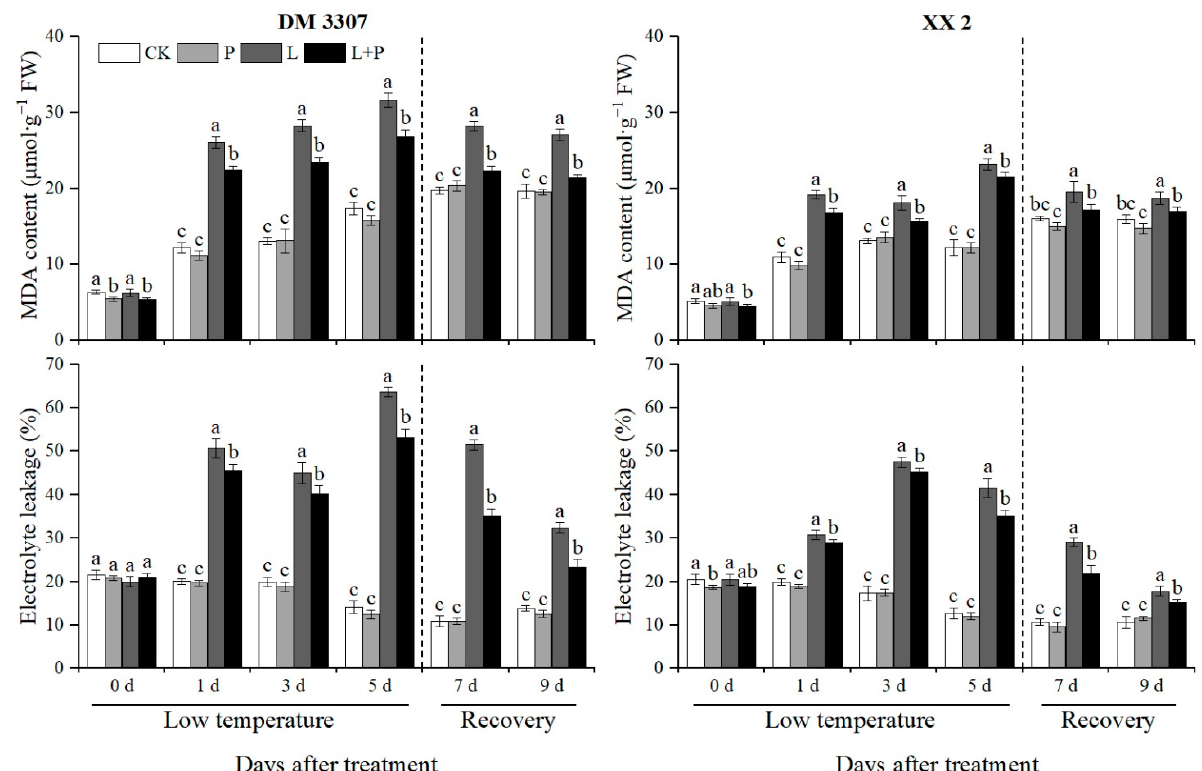
Figure 1. Effect of exogenous proline on MDA content and EL in embryos of maize under low − temperature stress. Notes: Data are expressed as mean ± standard deviation. Different letters within the same column indicate significant differences at the 5% level. CK: control group; P: proline treatment; L: low − temperature stress treatment; L + P: low − temperature stress + proline combined treatment. Different small letters represent significant differences between treatments ( p < 0.05).